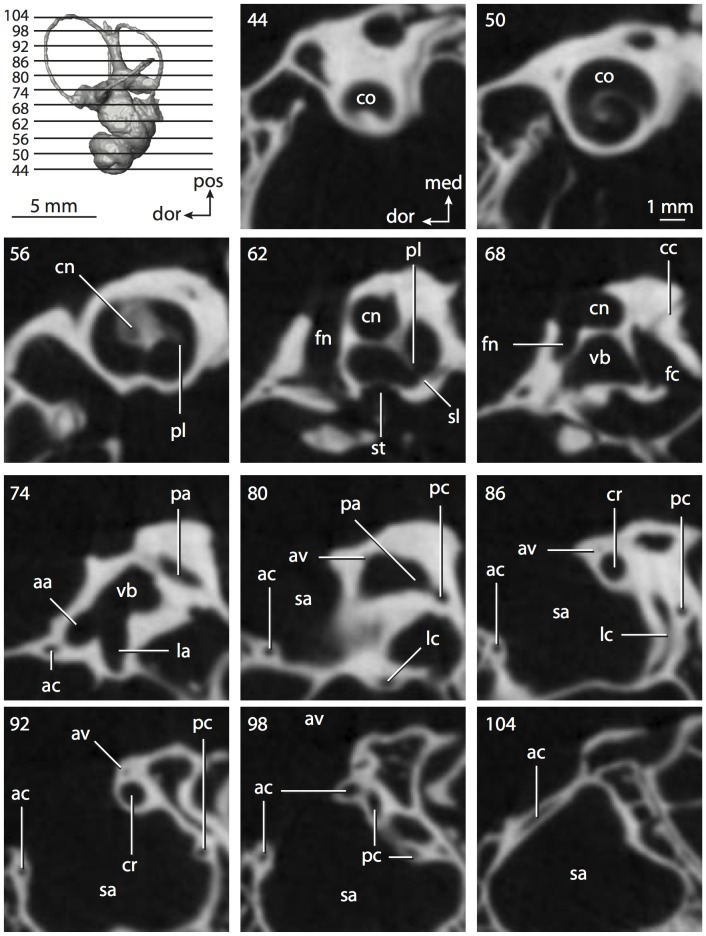
CT slices through ear region ofLepus californicus.Abbreviations listed at the end of the Materials and Methods section.